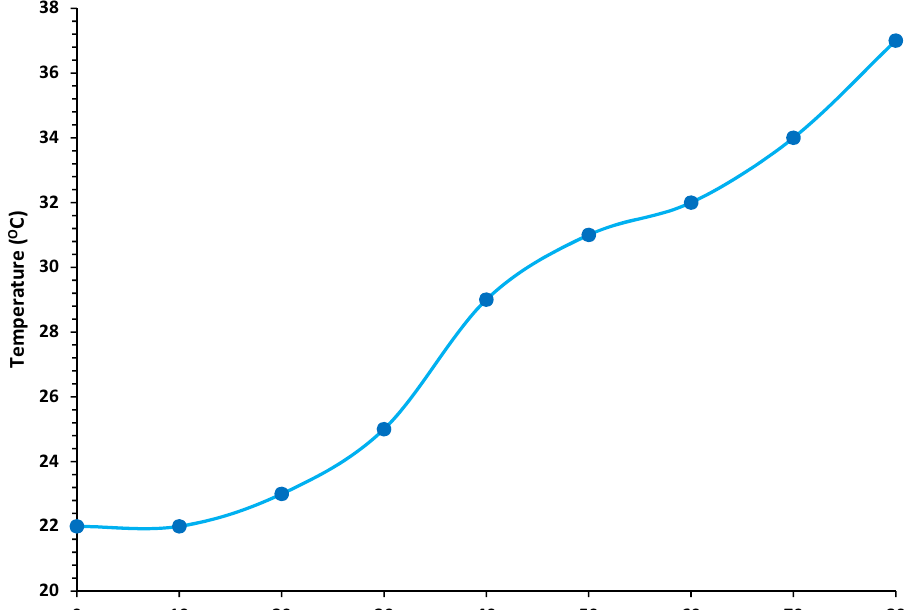
Fig. 10 Changes in water